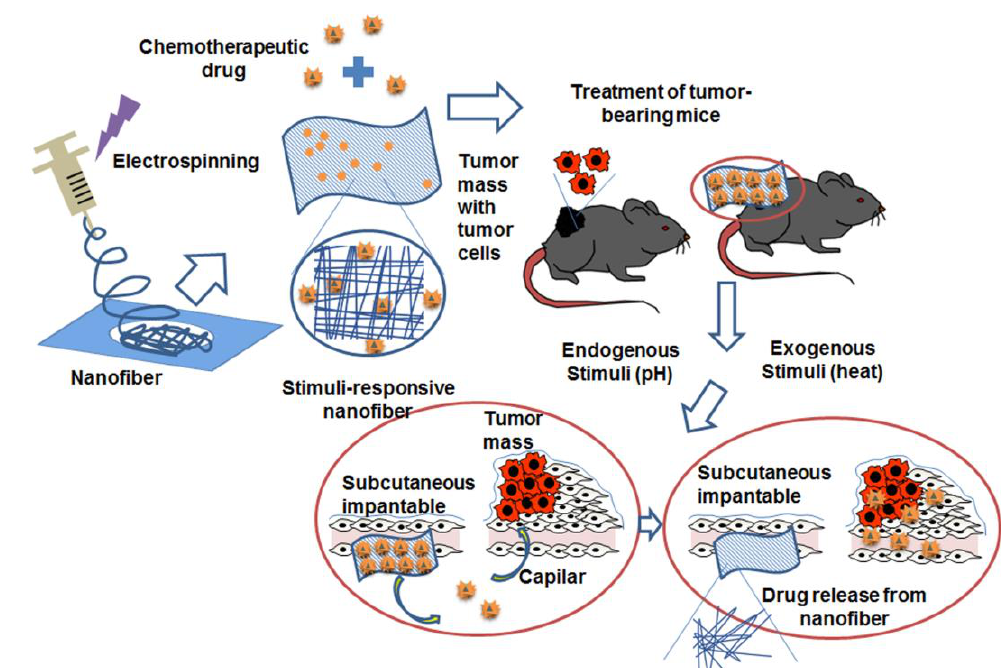
Figure 4. Stimuli-responsive NFs. Once NFs are synthesized by the electrospinning process and loaded with the antitumor drug, treatment may be applied in an experimental mouse model that carries a specific type of tumor. Once the treatment has been inoculated, an internal stimulus, such as the low pH present in the tumor tissues, or an external stimulus such as a temperature rise, stimulate the release of the drug at the specific site of the tumor, thus applying the treatment on tumor cells. Reprinted with permission from reference [62]. Copyright American Chemical Society, 2016.